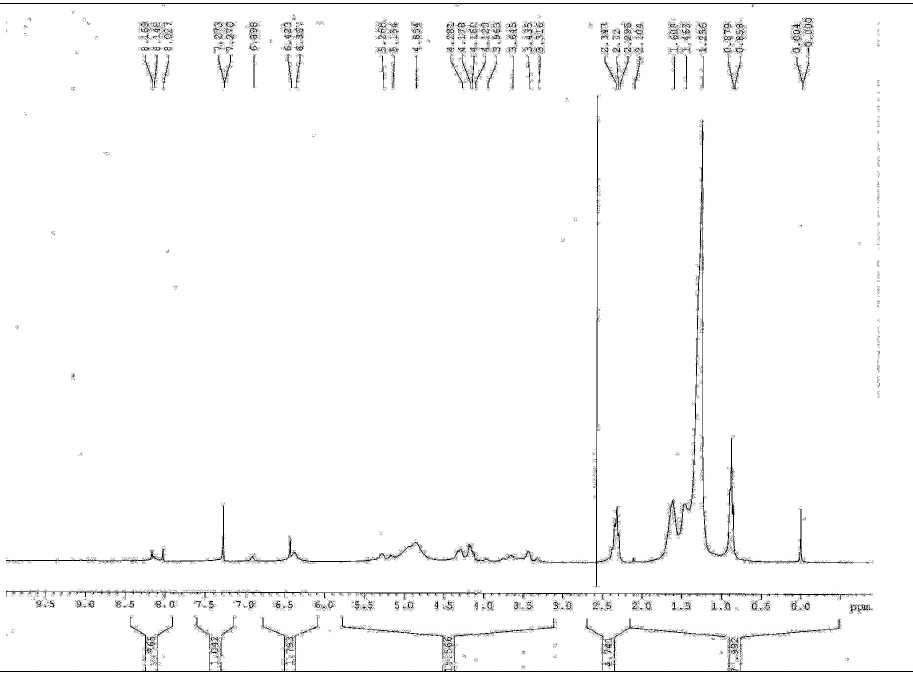
Figure 8. NMR spectrum of o -PTF olive